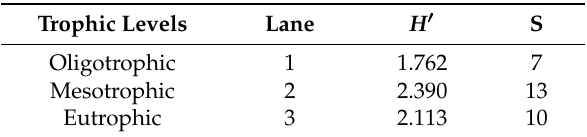
Table 3. Lake biodiversity of three trophic levels based on DGGE banding data analysis of DNA fragments sampled from algal microcosms.